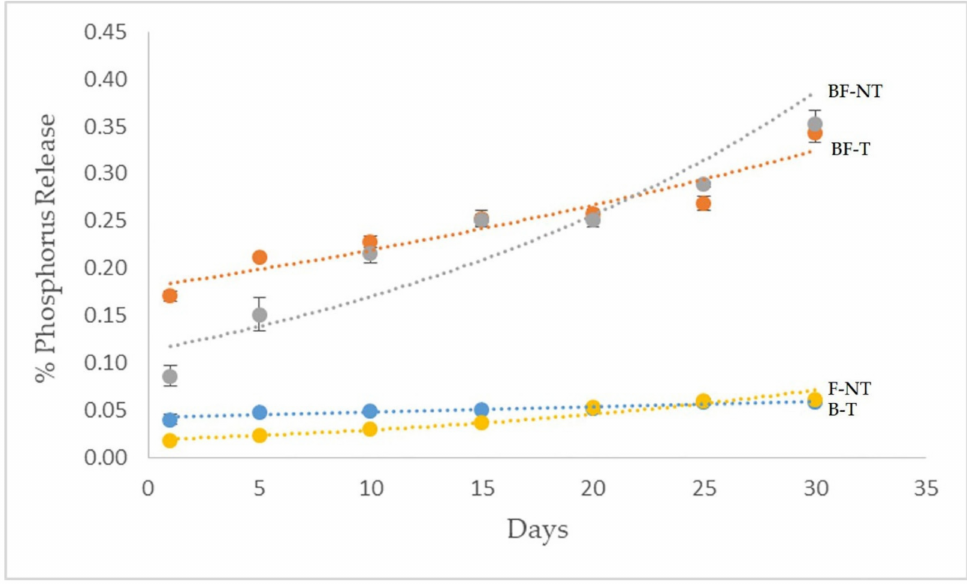
Figure 7. Percent phosphorus release of total P applied at five day intervals for 30 days of a water incubation